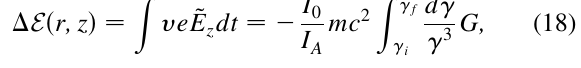
(cid:4) 0 , 1, 2, and 3; this number z